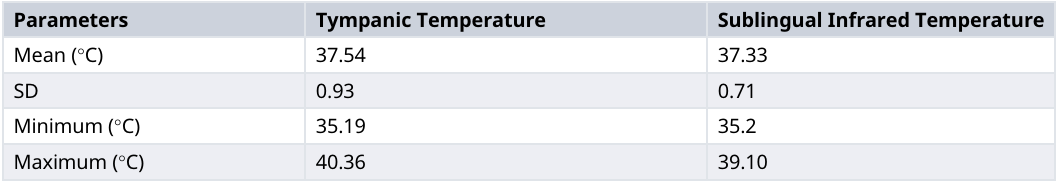
Table 1. Basic statistical values of tympanic and sublingual infrared temperature recordings.